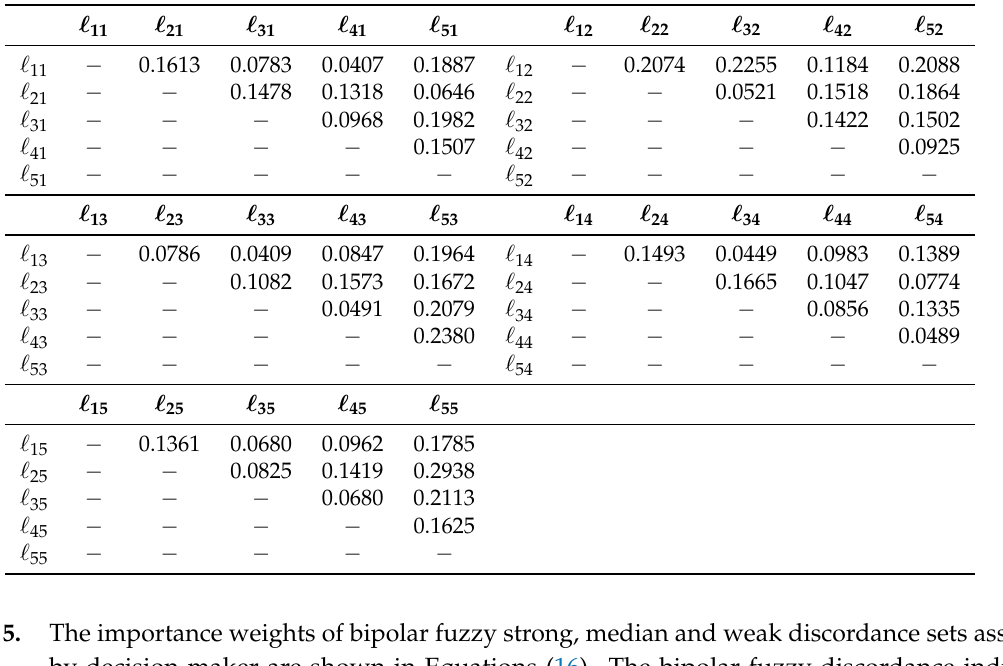
Table 2. Bipolar fuzzy weighted